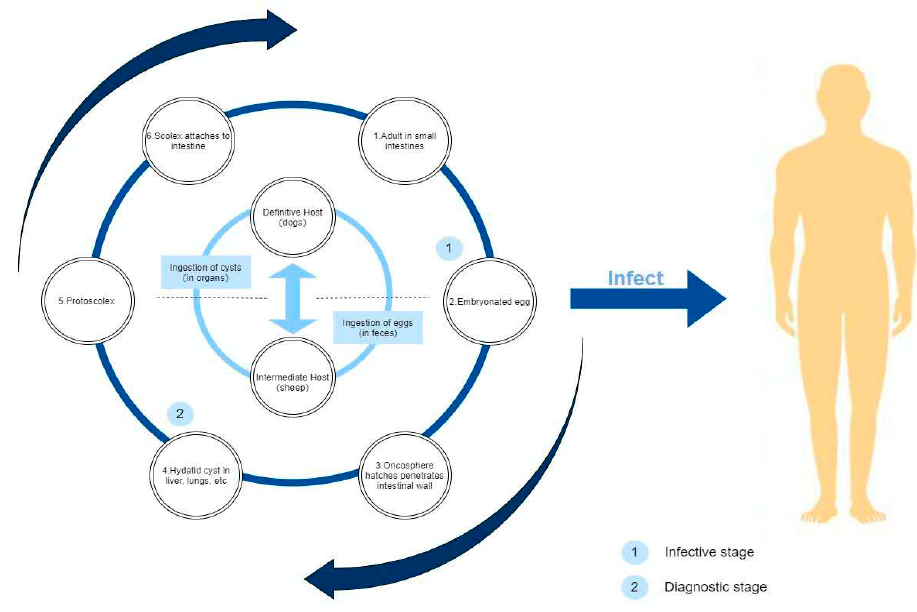
Figure 2. Flow chart of hydatid growth and infection.